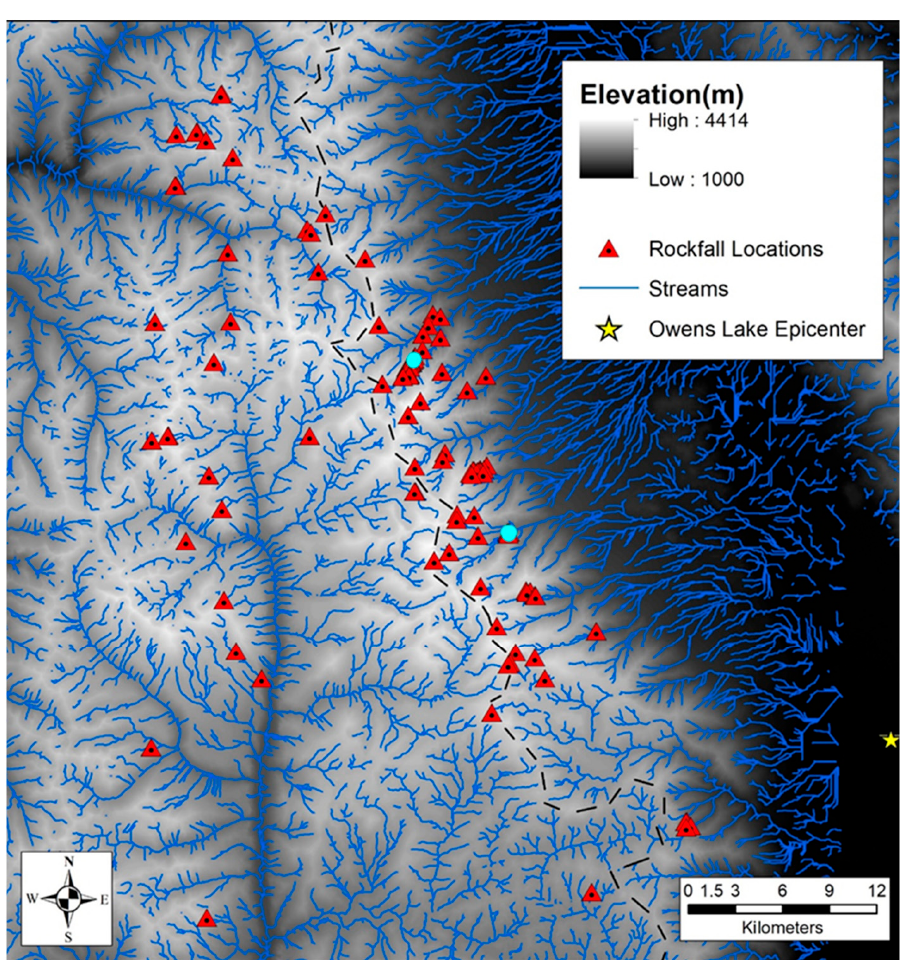
Figure 11. Rockfall Distribution from the M W 5.8 24 June 2020 Owens Lake Earthquake. Light blue dots represent major rockfalls within the area. Central blue dot represents the Whitney Portal rockfall illustrated in Figure 13. Upper blue dot represents the large Williamson Creek rockfall illustrated in Figure 17. Black dashed line approximates the Sierra Nevada crest.